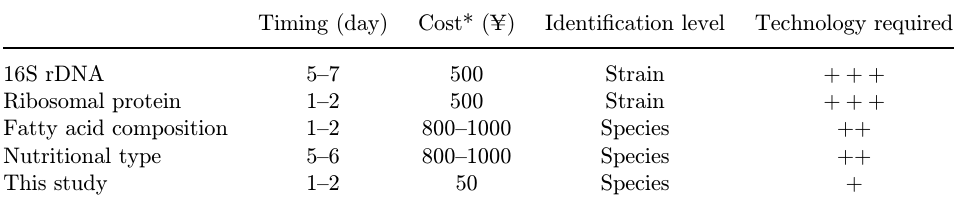
Table 5. Comparison between biochemical and genotypic analysis method and the SIM imaging-based method in this